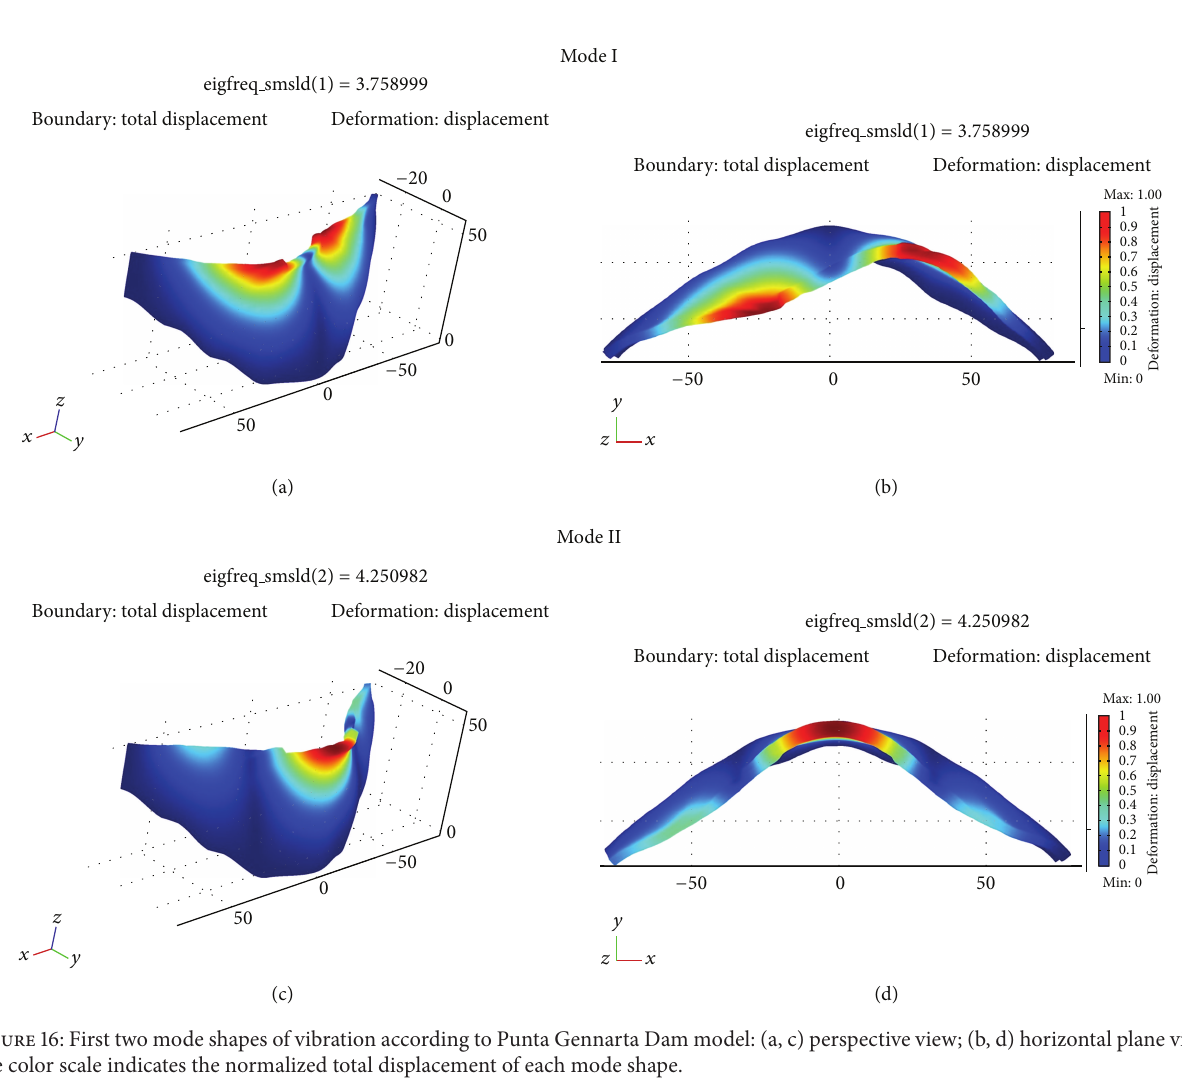
Figure 15: Some pictures of the 3D mesh used for the finite element analysis of Punta Gennarta Dam (a) upstream side view; (b) downstream side view.